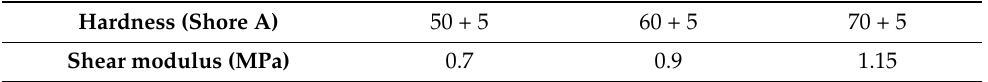
Table 3. Shear modulus (G g ) and hardness (Shore A): EN 1337-3 Annex D: Shear Modulus Com- ments.